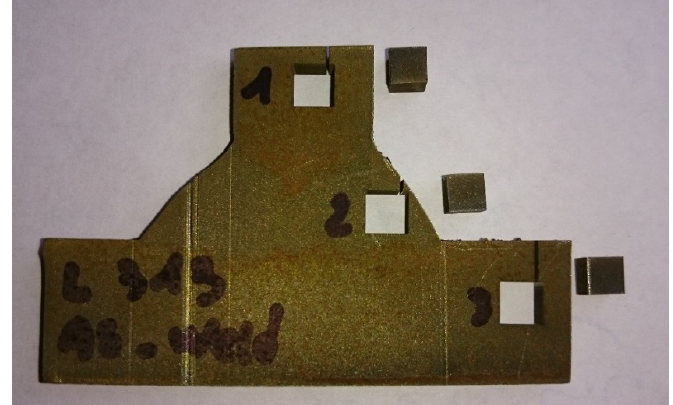
Figure 3. Cubes machined from the base and weld metal (stress-free sample) used for the reference lattice spacing ( d 0 ) measurements.